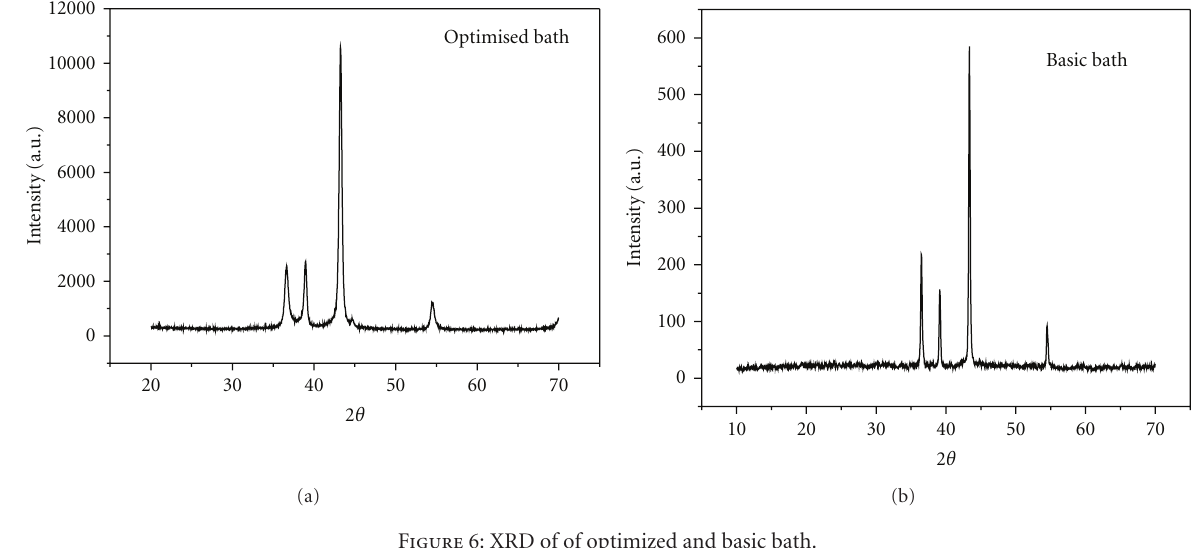
Figure 6: XRD of of optimized and basic bath.